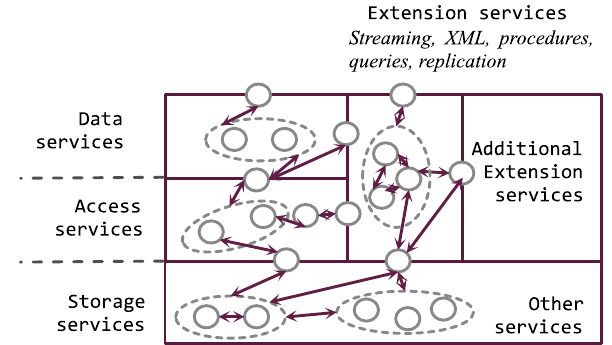
Fig. 7 Service-oriented DBMS